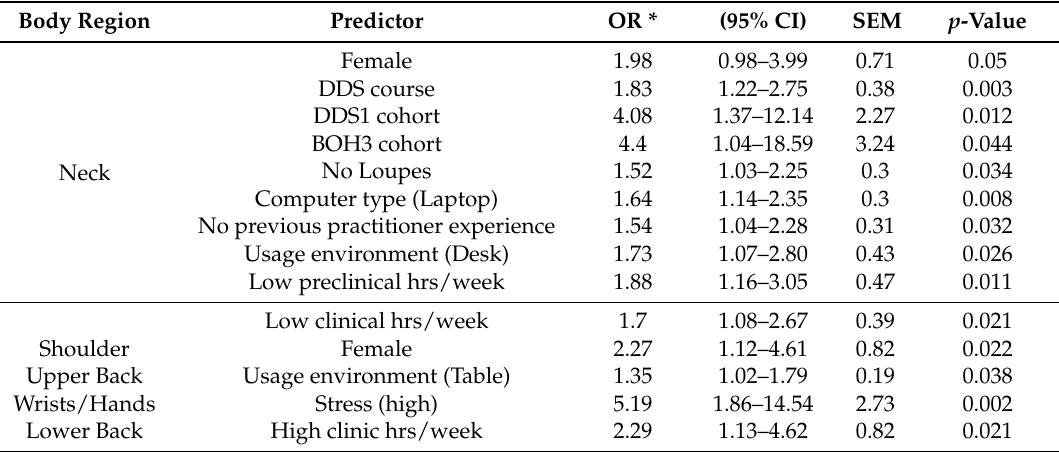
Table 6. Statistical correlates and predictors of MSD.